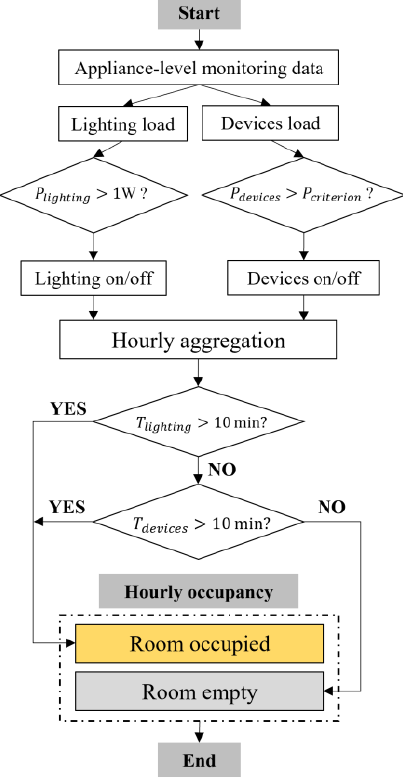
Figure 2. Scheme of hourly occupancy schedule detection.